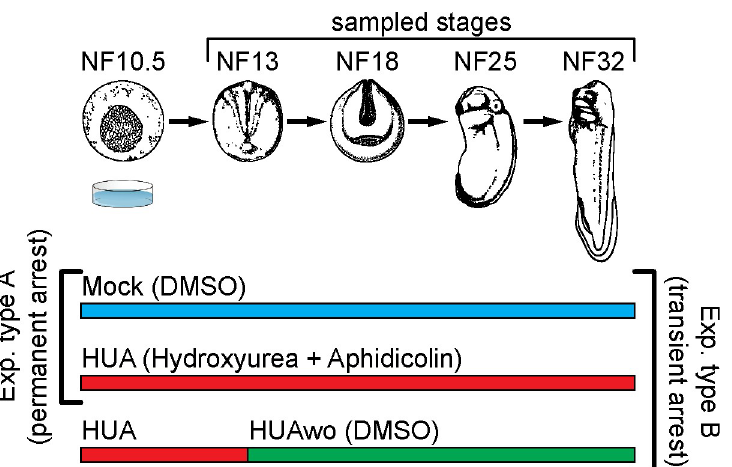
Fig 1. Experimental design. Top part: a schematic representation of Xenopus laevis embryonic development. Developmental stages (NF) according to Nieuwkoop and Faber (1994). Stages used for mass spectrometry of histone modifications and embryonic analyses are characterized by the following features: NF13—late gastrula, germ layer specified; NF18—neurula, germ layer patterning and differentiation; NF25—tailbud stage, organogenesis; NF32—early tadpole, body plan established. Bottom part: We perform 2 types of experiments: Experiment type A (G1/S block)— embryos are split in 2 groups, which from NF10.5 on are continuously incubated in HUA solution or control solution (DMSO as carrier). Experiment type B (transient arrest)—embryos are split in 3 groups: continuous Mock, continuous HUA, and transient HUA. In the last group, HUA solution is replaced at NF13 with DMSO solution. DMSO, dimethyl sulfoxide; HUA, hydroxyurea and aphidicolin; HUAwo, HUA